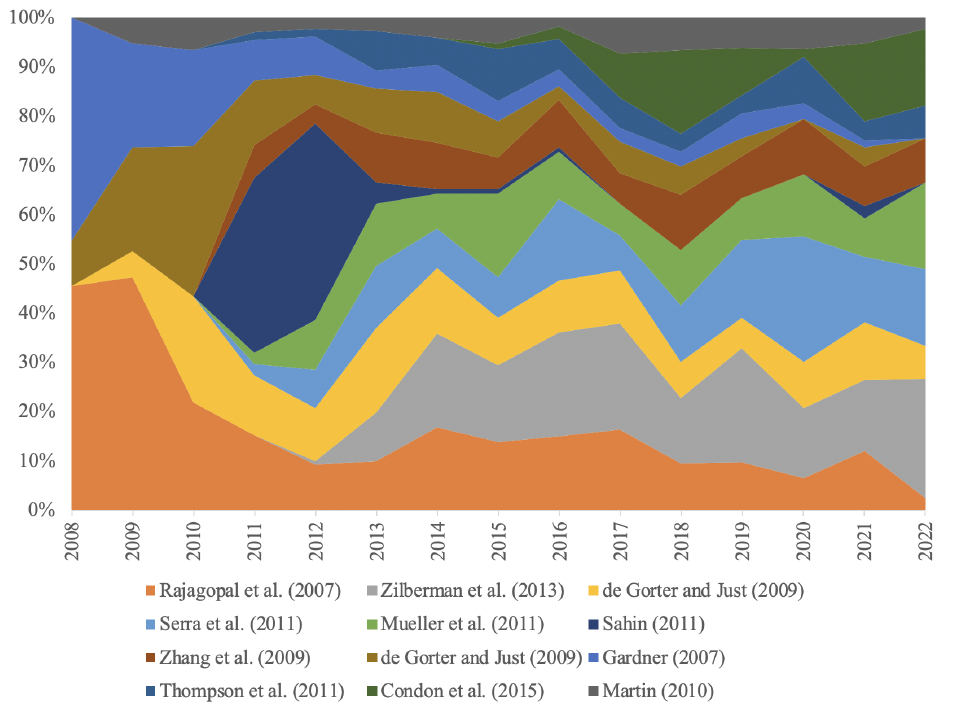
Figure 7. Distribution of citations over time for ten of the most cited articles in the sample.